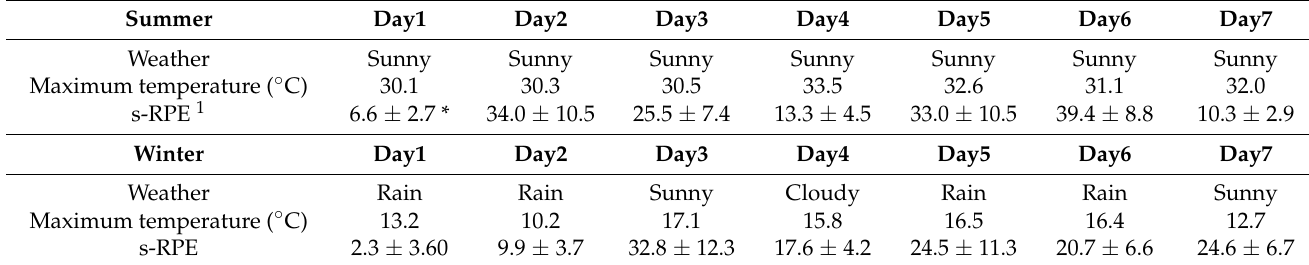
Table 3. The weather and maximum temperatures during the summer/winter camps.